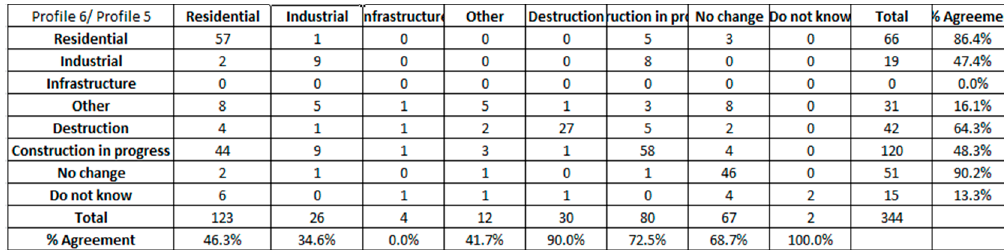
Figure 16. Boxplots showing the median values of producer’s accuracies by user profile.